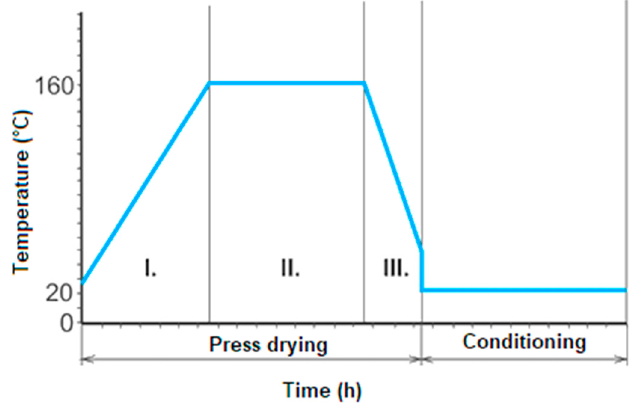
Figure 3. Contact-drying mode.